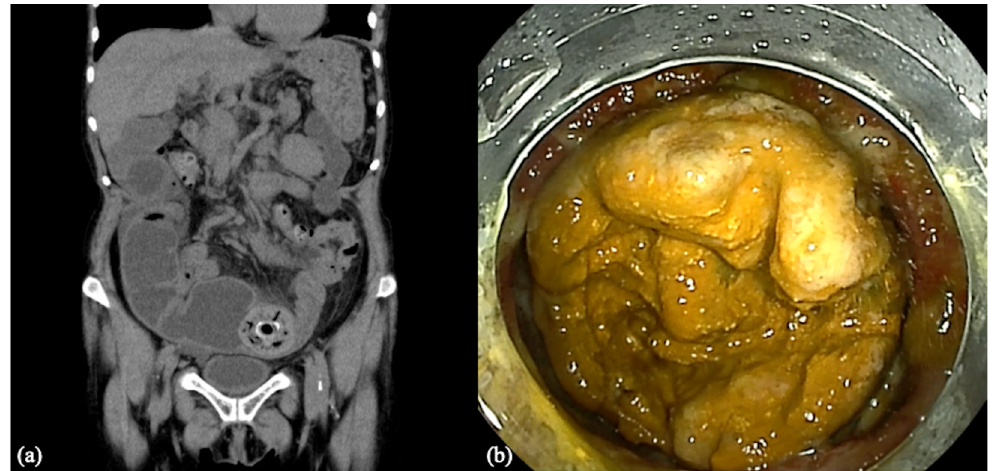
Figure 1. ( a ) Dilation of the small intestine and findings of an enterolith on CT. ( b ) Endoscopic view of the enterolith in the small intestine.